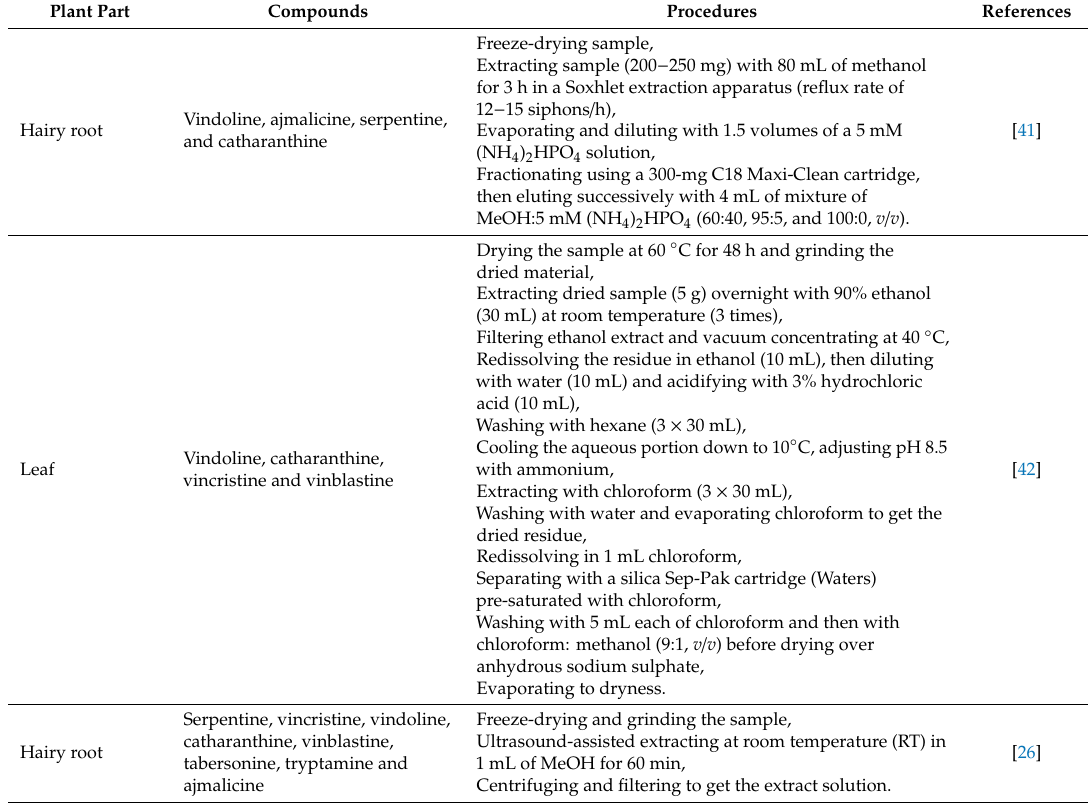
Table 4. Preparation and recovery of bioactive compounds from C. roseus